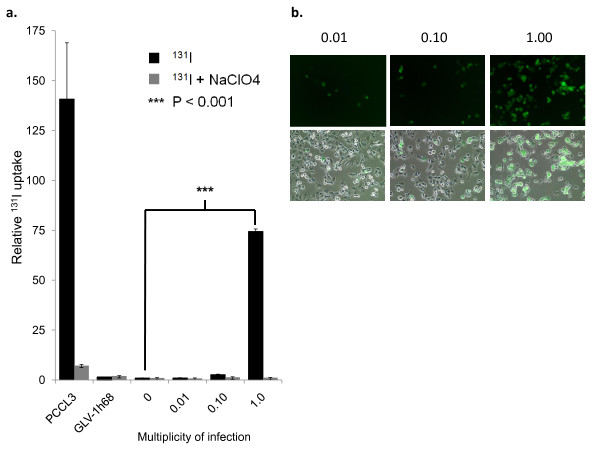
Assessment of in vitro 131I radiouptake of GLV-1h153-infected PANC-1 cells. a. PANC-1 cells were infected with an MOI of 0, 0.01, 0.1, and 1.0 of GLV-1h153 and MOI of 1.0 of GLV-1h68. PCCL3 was used as a positive control. Twenty-four hours after infection, there is a >70-fold enhanced radiouptake at an MOI of 1.0 as compared to an MOI of 0 in GLV-1h153, and radiouptake is shown to be MOI dependent and hNIS specific (as shown with blocking with competitive inhibitor of hNIS, NaClO4). b. Maximum radiouptake with an MOI of 1.0 24 hrs after infection corresponded to maximum GFP expression.